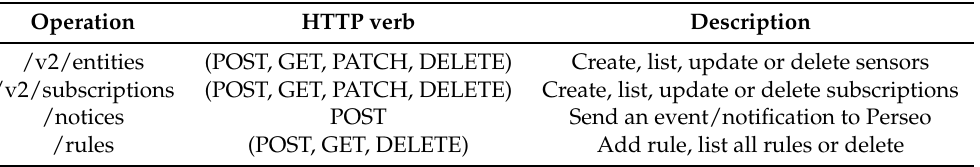
Table 4. Operations available at REFlex